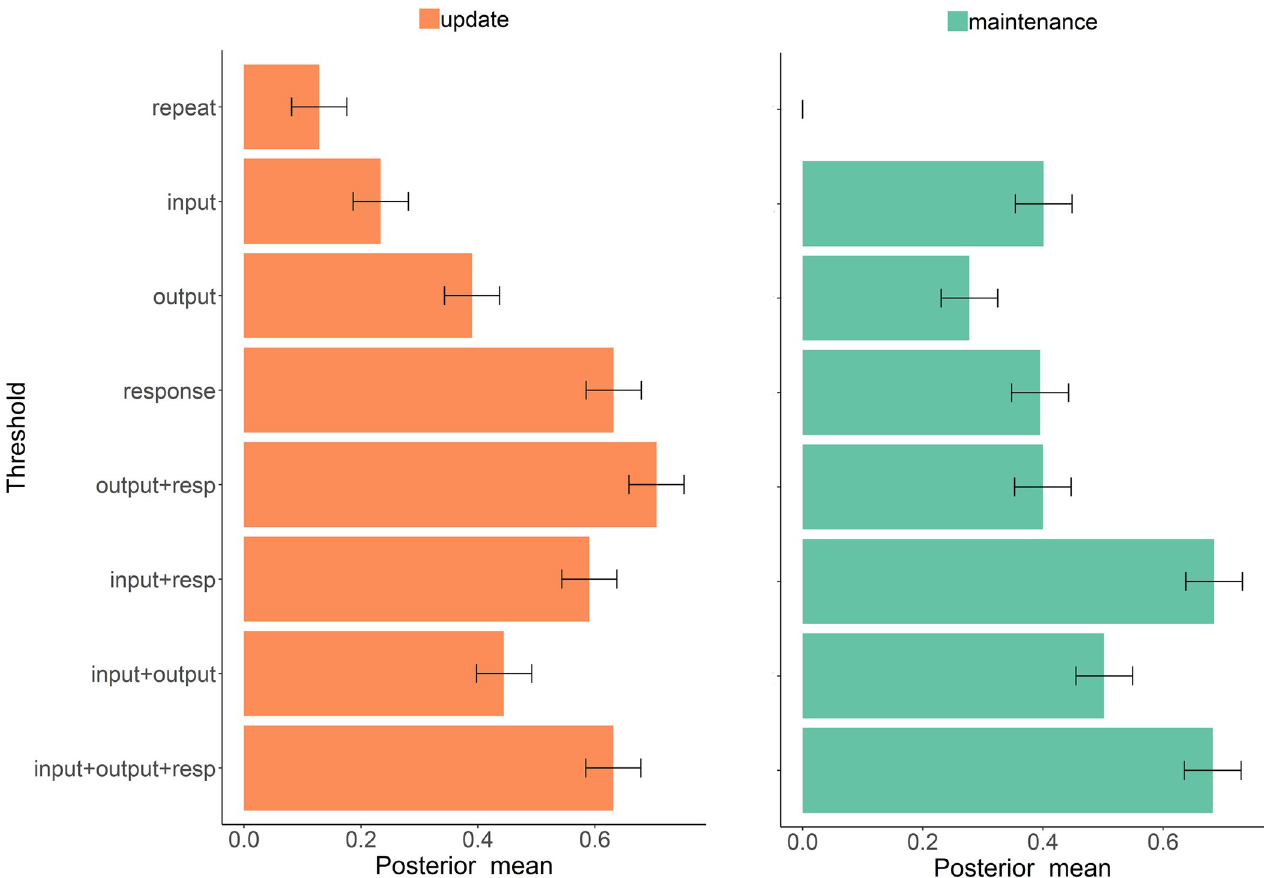
Fig 7. Under-additive interaction between gating selections. Decision threshold parameter estimates from HDDM in updating (orange bars) and maintenance trials (green bars), exhibit main effects of gate switching at each independent level of gating (input, output, and response), and under-additive interactions between gate switches in input-output, input-response, and output-response. Error bars reflect within-subject 95% highest density interval of the posterior distribution, in each case relative to maintenance repeat trials.